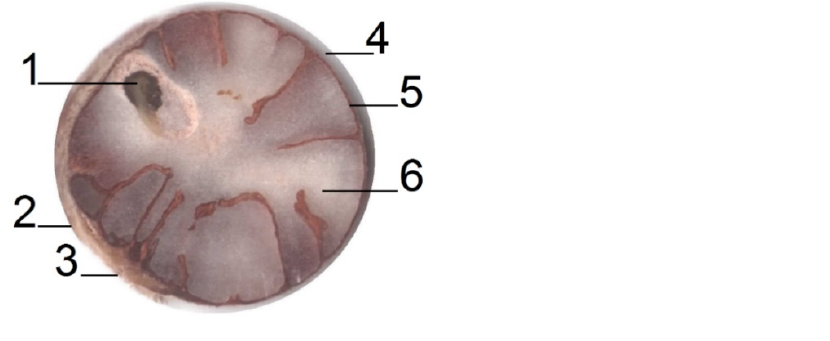
Figure 2. Anatomy of the açaí fruit (cross-section): ( 1 ) Embryo, ( 2 ) Endocarp, ( 3 ) Scar, ( 4 ) Pulp, ( 5 ) Pericarp + Tegument, and ( 6 ) Mesocarp [19].